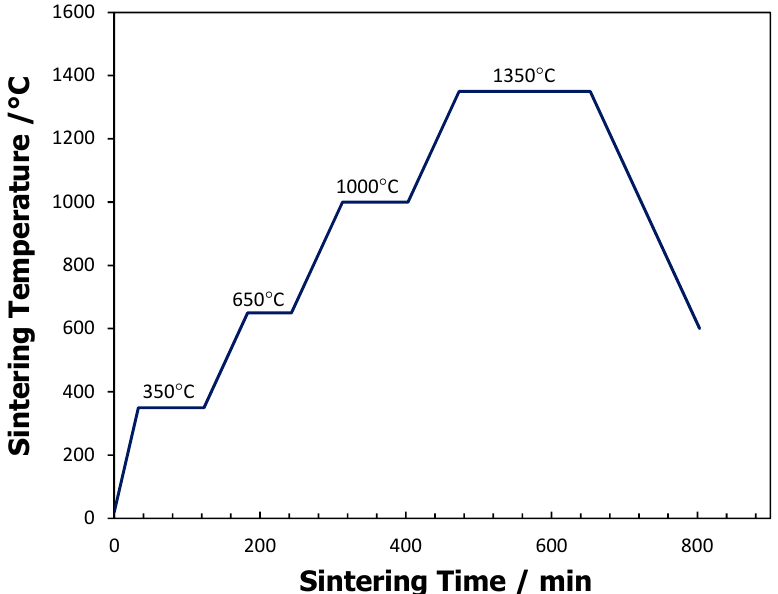
Figure 1. Temperature-time diagram for the sintering procedure of cold pressed